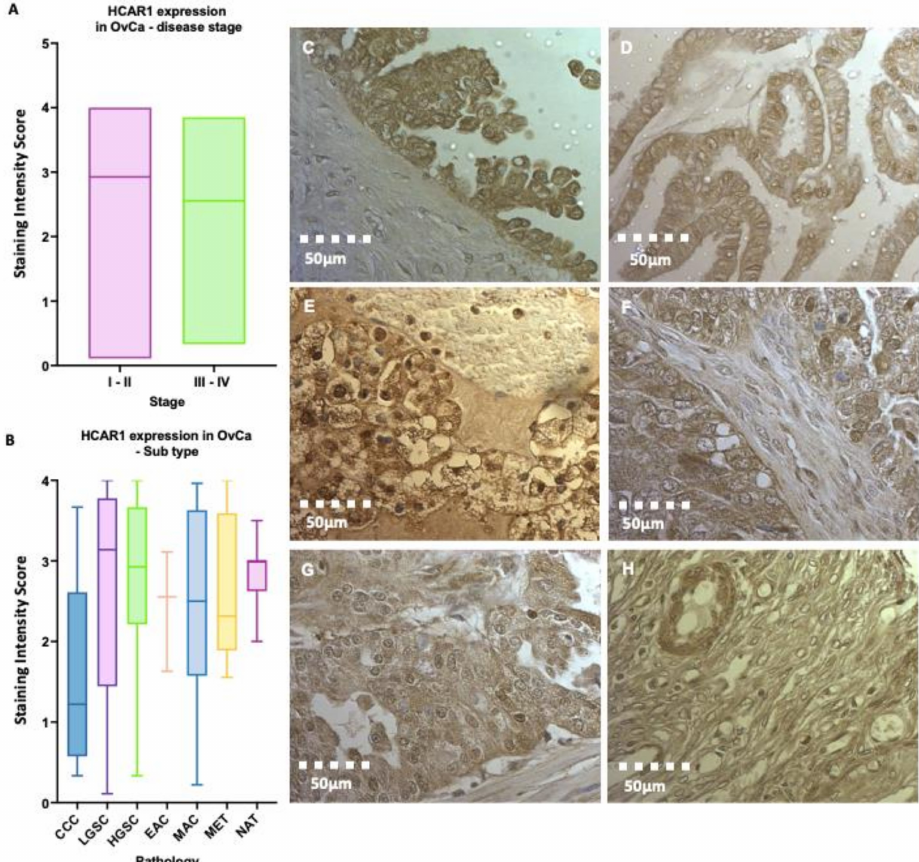
Figure 4. Expression of HCAR1 (hydroxycarboxylic acid receptor 1, HCAR1; formerly known as GPR81) in an ovarian tissue microarray containing biopsies from 90 patients with ovarian cancer (OvCa), in addition to 10 normal adjacent tissue (NAT) samples. ( A ) Intensity of tissue stained for early (I–II, n = 62) and late stage (III–IV, n = 18) OvCa, (no significance: ns); ( B ) Intensity of HCAR1 staining categorised by OvCa subtype: clear cell carcinoma (CCC), high-grade serous carcinoma (HGSOC), low-grade serous carcinoma (LGSOC), endometrioid adenocarcinoma (EAC),